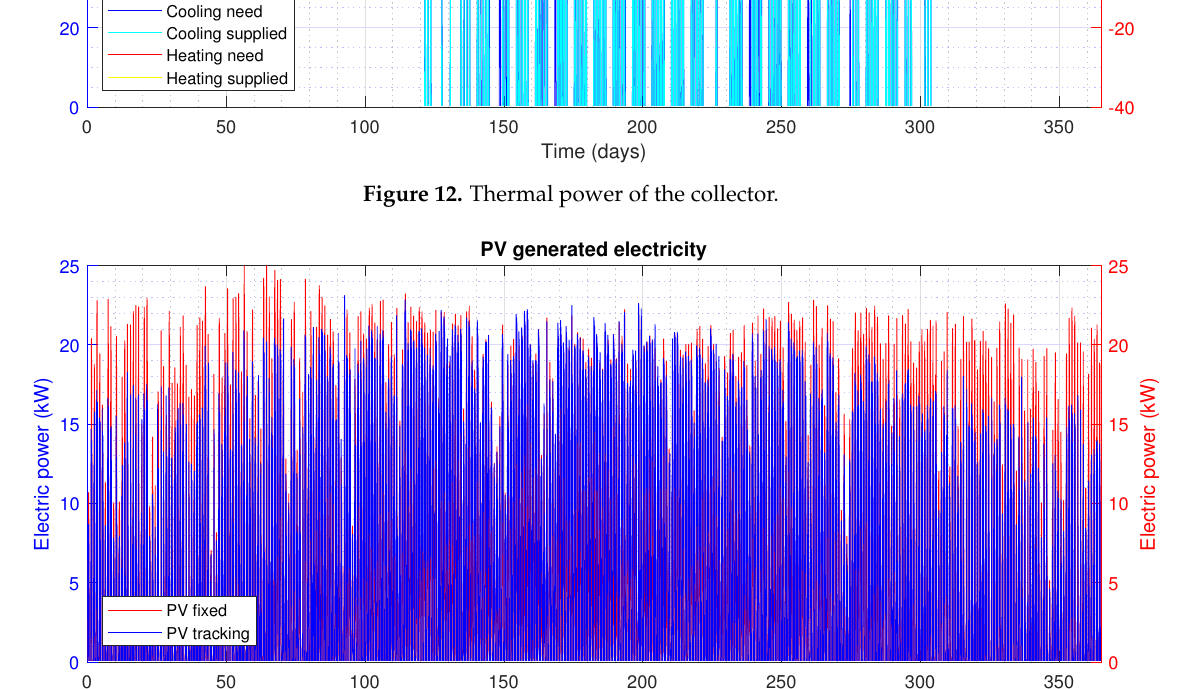
Figure 13. Electricity generated by the